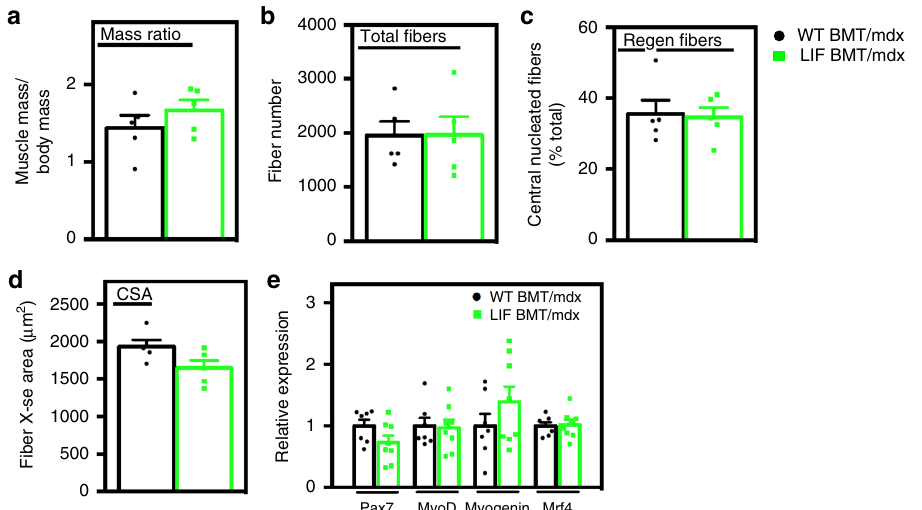
Fig. 9 Transplantation of CD11b/LIF transgenic BMCs does not affect muscle growth or regeneration. Assays of muscle mass to body mass ratio ( a ), fi ber number ( b ), proportion of centrally-nucleated regenerating fi bers ( c ), and muscle fi ber cross-sectional area ( d ) indicate no difference in muscle growth or regeneration between WT BMT/ mdx and LIF BMT/ mdx recipients. N = 5 per group. For all histograms in the fi gure, the bars indicate mean ± sem. e QPCR analysis shows no difference in the expression of myogenic transcription factors ( Pax7 , Myod1 , Myog , and Mrf4 ) in WT BMT/ mdx versus LIF BMT/ mdx recipients. N = 7 or 8 for WT BMT/ mdx and LIF BMT/ mdx data sets, respectively. No signi fi cant differences were identi fi ed between groups at P < 0.05, determined by two-tailed t- test. Source data are provided as a Source Data fi